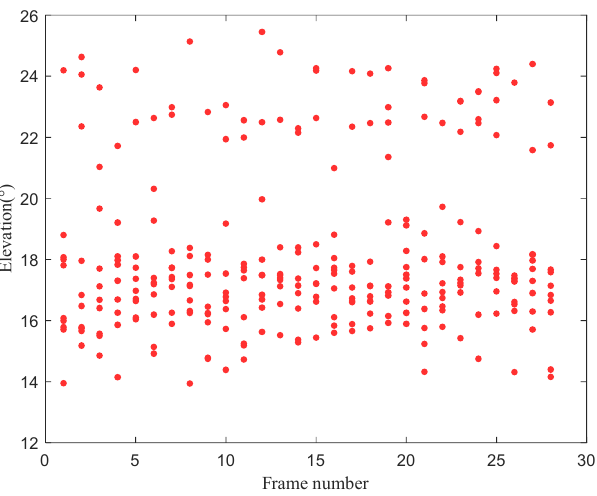
Figure 18. Illustration of the signal’s elevation angle varying with time.